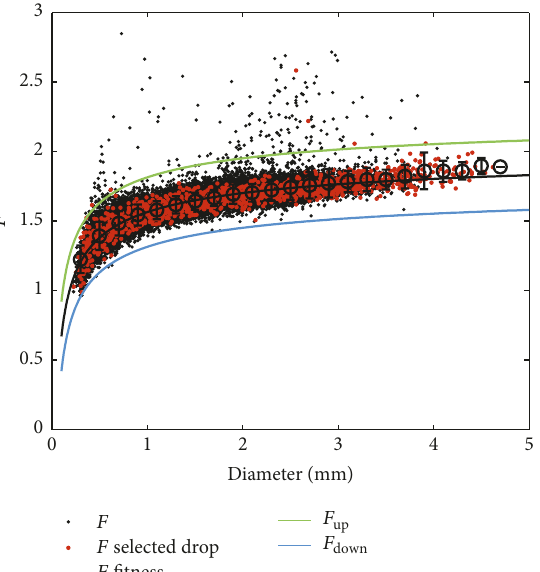
Figure 15: The scatter plot between the 𝐹 and diameter of raindrops. The black dots represent the result from raw images rejected by 𝑃 and 𝐸 , while the red dots represent the result from valid images.